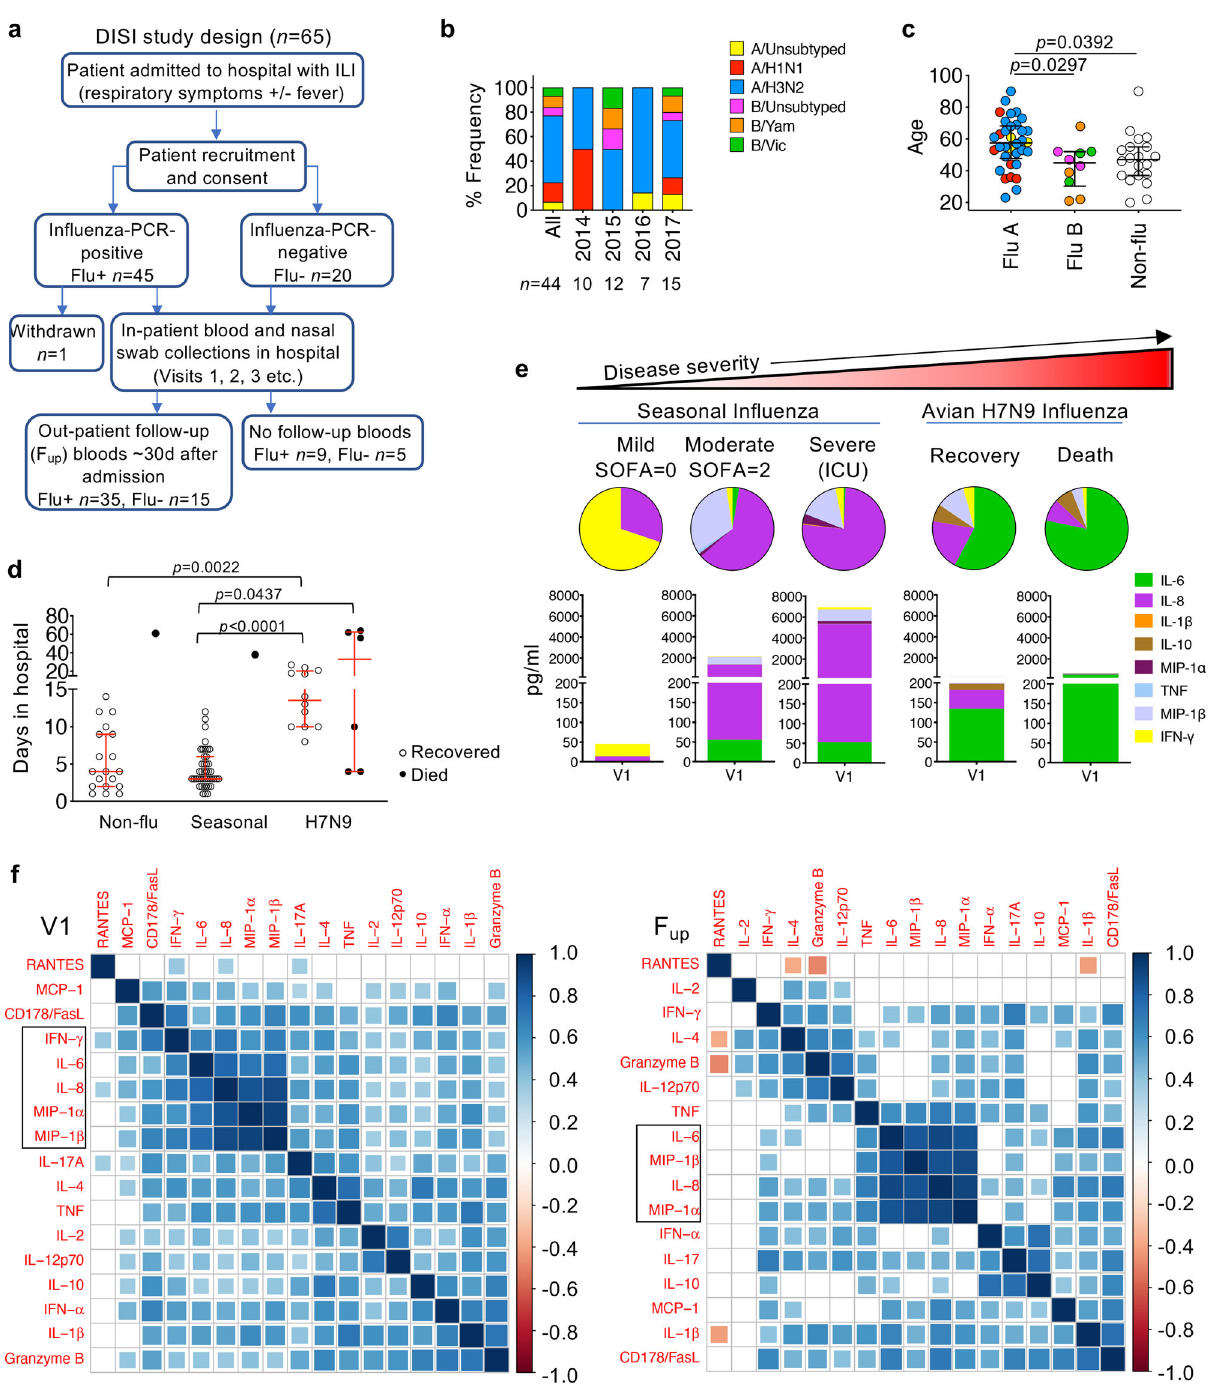
Fig. 1 Cluster analysis of patient clinical information, genetic characteristics and in fl ammatory cytokines. a Flow chart of study design. b Frequency of patients infected with seasonal in fl uenza virus strains. N values are below for total and for each year. c Age distribution by in fl uenza A (3 unsubtyped, 7 H1N1, 24 H3N2), in fl uenza B (3 unsubtyped, 4 YAM, 3 VIC) and in fl uenza-negative (Non- fl u, Flu-) patients ( n = 20). Virus strain colors match those in ( b ). d Days in hospital for DISI cohort and H7N9 cohort. c , d Bars indicate the median and IQR, statistical signi fi cance (0.0001 > p < 0.05) was determined using the Kruskal – Wallis test (two-tailed). e Representative serum levels and distribution of pro-in fl ammatory cytokines in patients, measured within the fi rst 2 – 3 days of hospital admission (Visit 1, V1), with varying disease severity. f Partial correlation plots showing the degree of correlation between every chemokine/cytokine pair in in fl uenza + patients at V1 and F up . The color corresponds to the correlation coef fi cient and the size of the colored squares correspond to the FDR-adjusted p value. Correlations that are not signi fi cant ( p > 0.05) result in white boxes.